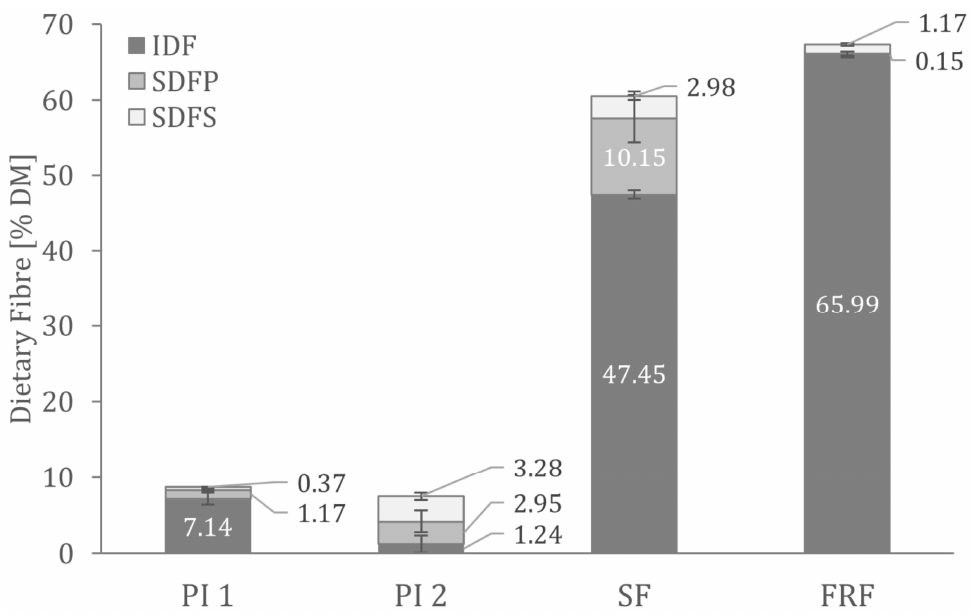
Figure 1. Dietary fibre composition in the analysed faba bean fractions. IDF—insoluble dietary fibre; SDFP—high molecular weight soluble dietary fibre; SDFS—low molecular weight soluble dietary fibre.